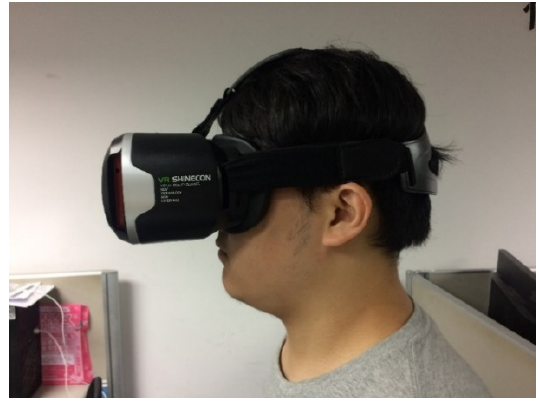
Figure 5. The head-mounted device.